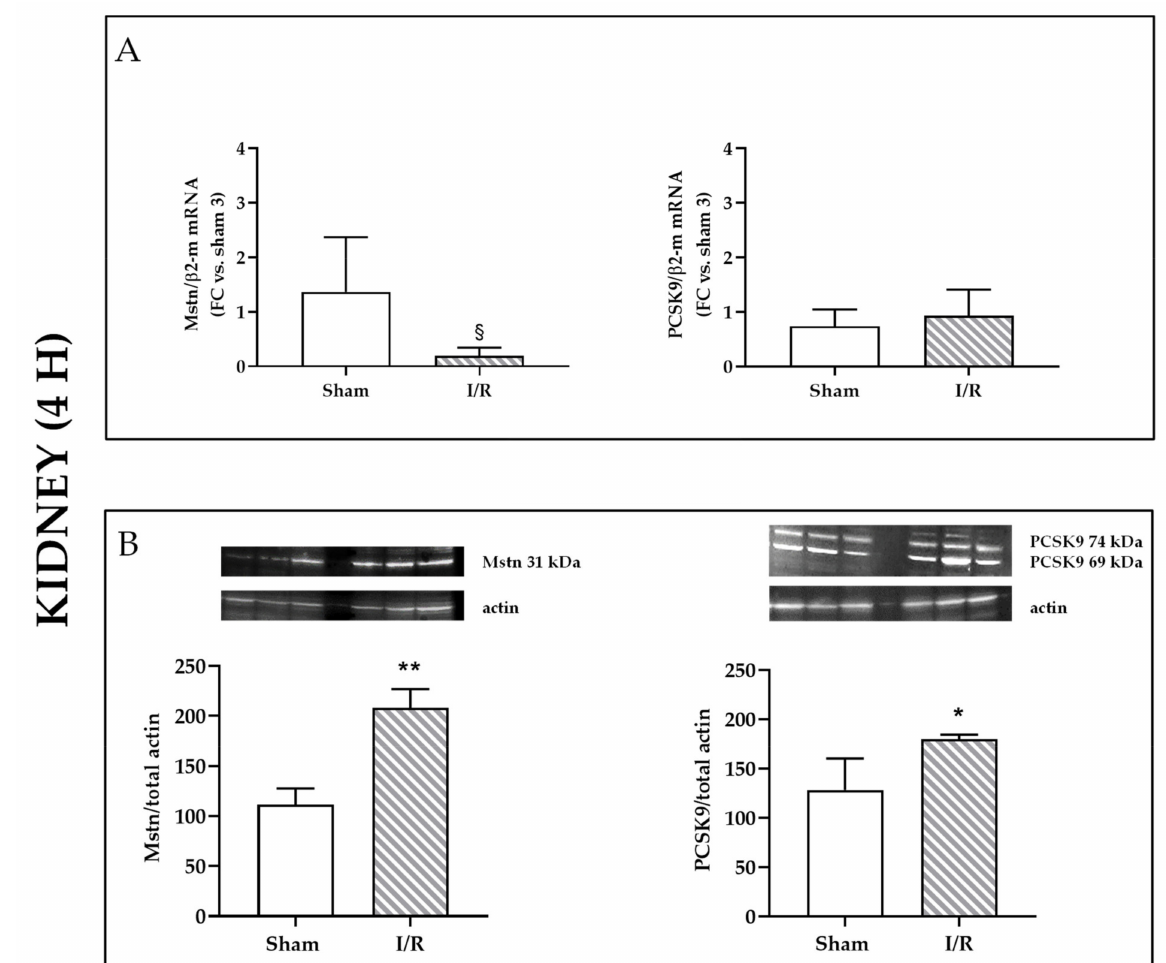
Figure 1. Analysis of rat kidney homogenates after sham intervention or ischemia/reperfusion (I/R, 30 min/4 h). ( A ) Mstn and PCSK9 mRNA expression by quantitative real-time PCR. The results have been normalized by expressing the number of transcript copies as a ratio to β 2-microglobulin ( β 2-m) and indicated as fold changes (FC) in respect to kidneys from sham-operated rat (#3) (§ p = 0.05, one tailed analysis). ( B ) Western blot analysis of Mstn 31 kDa (left) and of PCSK9 74 and 69 kDa isoforms (right). Bands of interest were normalized against those obtained by membrane rehybridization with anti-total actin antibody. Representative immunoblots are shown. Data are expressed as % ± SEM in respect to sham-operated rat (#1); * p < 0.05, ** p <